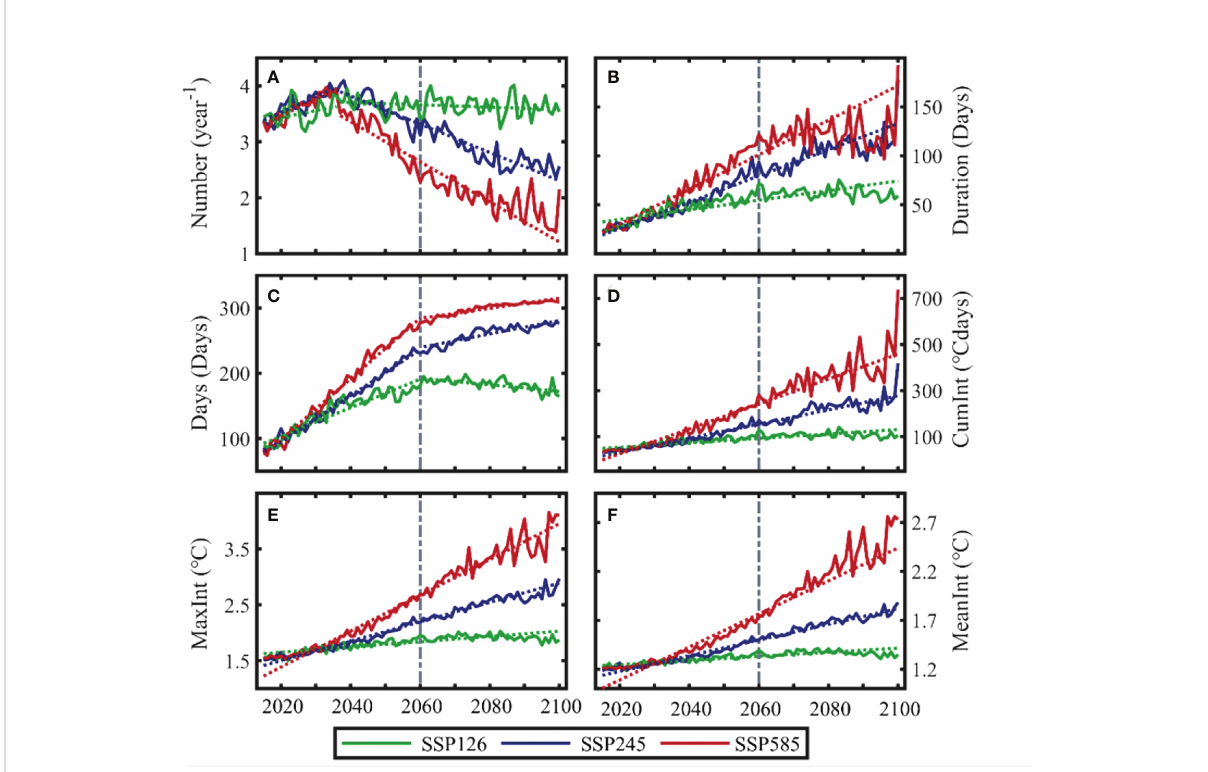
FIGURE 13 Projected interannual variability of MWHs parameters under the SSP1-2.6 (green line), SSP2-4.5 (blue line) and SSP5-8.5 (red line) scenarios from the ensemble mean of the four/ fi ve/ fi ve selected models. The solid line is the future change of the estimated parameters, and the dotted line is the linear regression result. The left side of the dotted line (2060) represents the near future scenario, and the right side of the dotted line represents the far future scenario. Interannual variability for MHWs (A) Number (unit: year -1 ), (B) Duration (unit: day), (C) Days (unit: day), (D) CumInt (units: °C days), (E) MaxInt (units: °C), (F) MeanInt (units: °C).